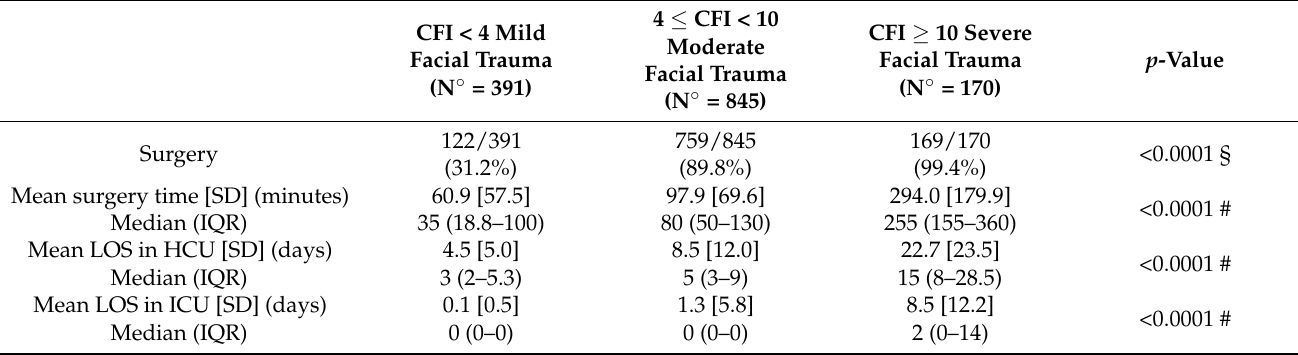
Table 4. Outcomes for mild, moderate, and severe facial trauma